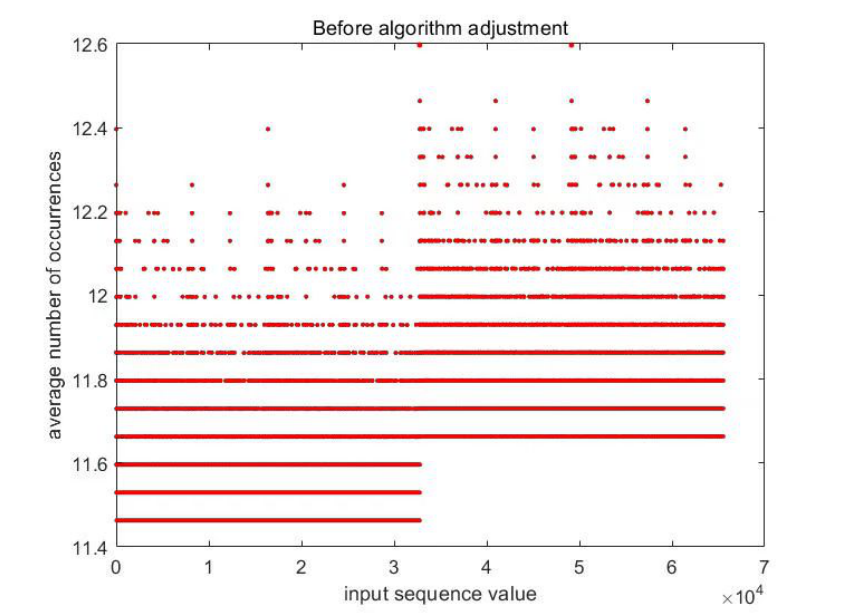
Figure 7. Mathematical expectation of the offset sequences in matrix A in the 2000 left-shift operations without Formula (24). The horizontal axis is the value of the input sequence; the vertical axis is the mathematical expectation of the offset